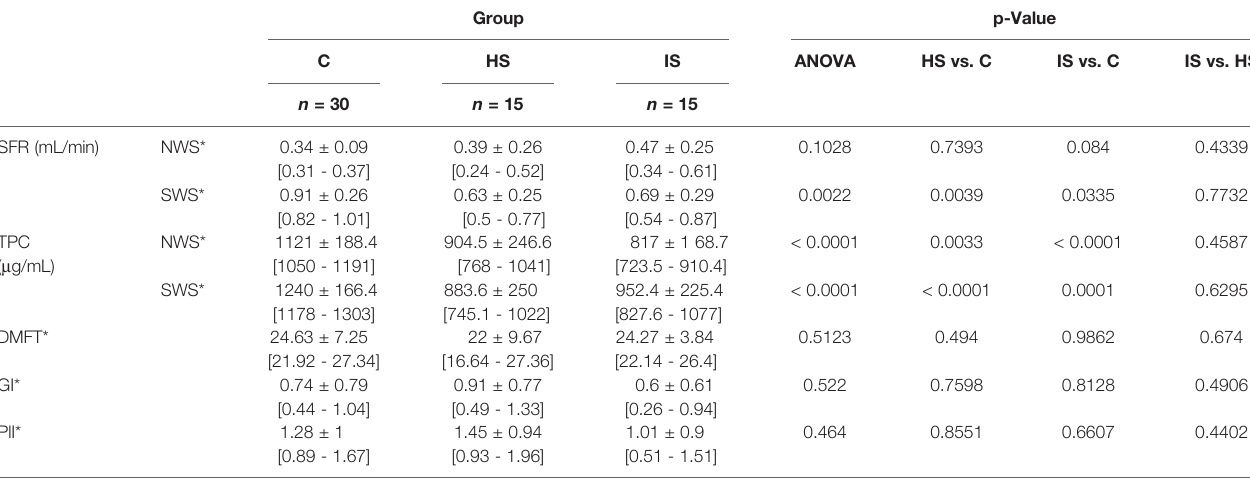
TABLE 3 | Salivary gland function and stomatological characteristics of the studies and control groups. Group p-Value C HS IS ANOVA HS vs. C IS vs. C IS vs. HS